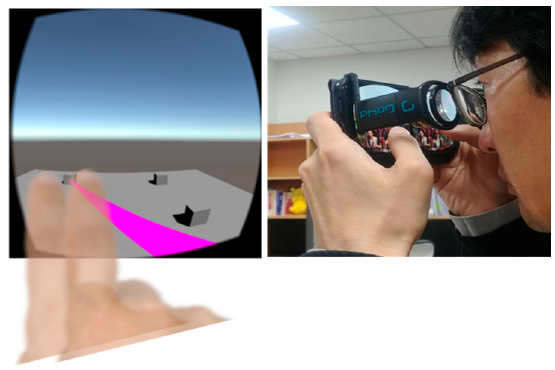
Figure 3. Directly selecting a virtual object with the finger on the touch screen. The touching finger is blurred, but because of it, the target object behind it is visible, and reasonably accurate selection is possible. Both two/one hand/finger interactions are possible.